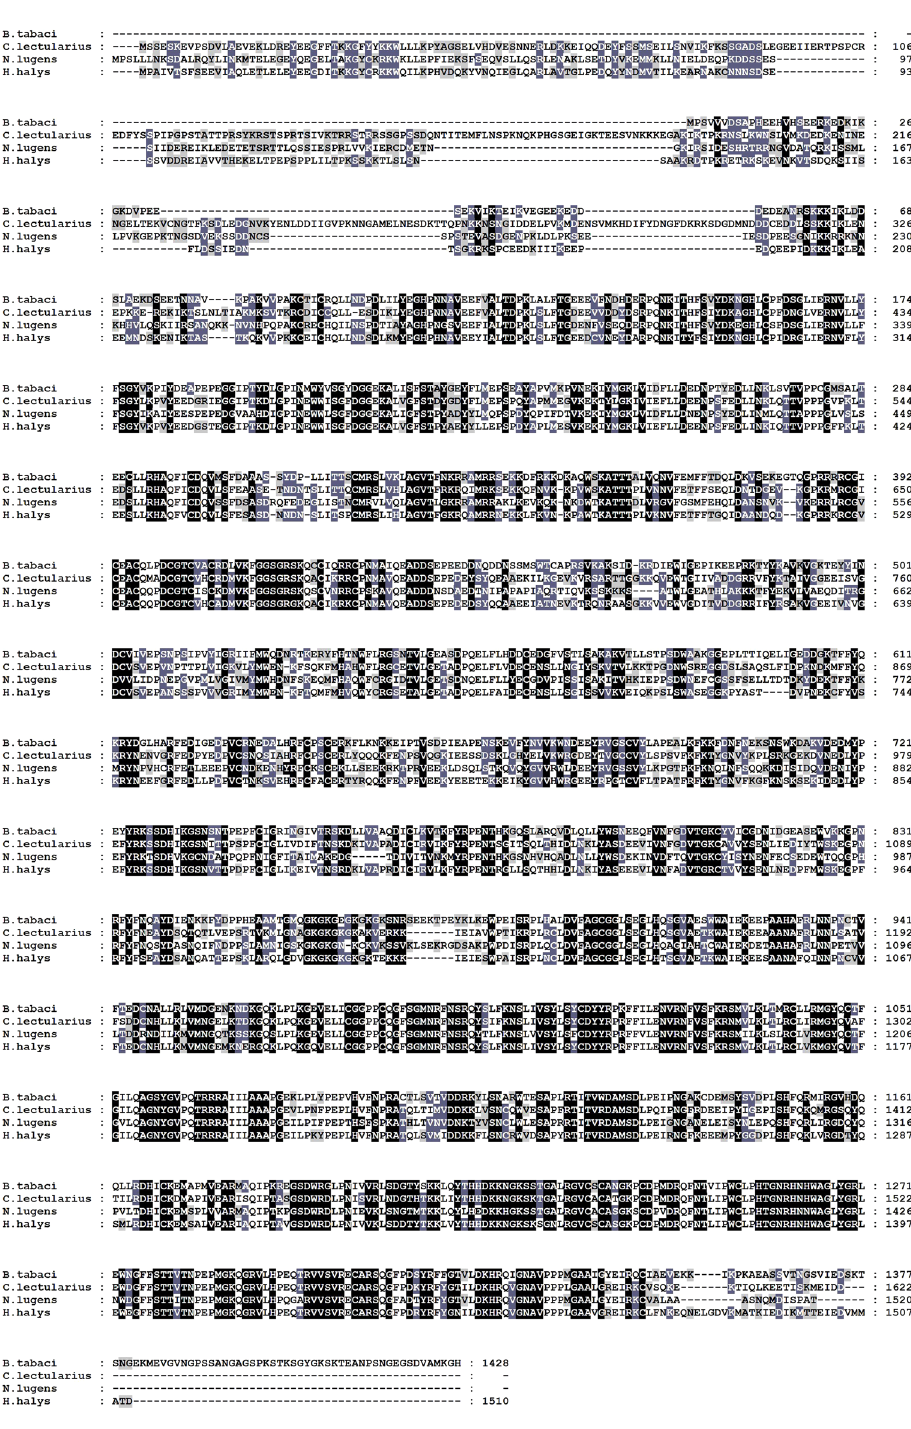
and Y = − 3.326 × + 48.642 (R 2 = 0.991) (Supplementary Figure 2), respectively. Injection of dsRNA targeting the EGFP gene as an unrelated control gene did not affect the expression of the BtDnmt1 gene studied in the three whiteflies indicating that the injection by itself did not interfere with gene expression. BtDnmt1 mRNA expression was significantly decreased in MED (F 3,20 = 9.033) and MEAM1 (F 3,20 = 4.936) compared to that in the control treatments after ds Dnmt1 feeding, but no significant difference in AsiaII3 (F 3,20 = 0.944) (Fig. 5).